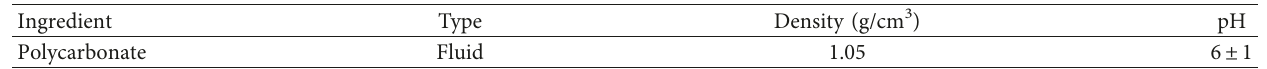
Table 8: Chemical properties of superplasticizer.